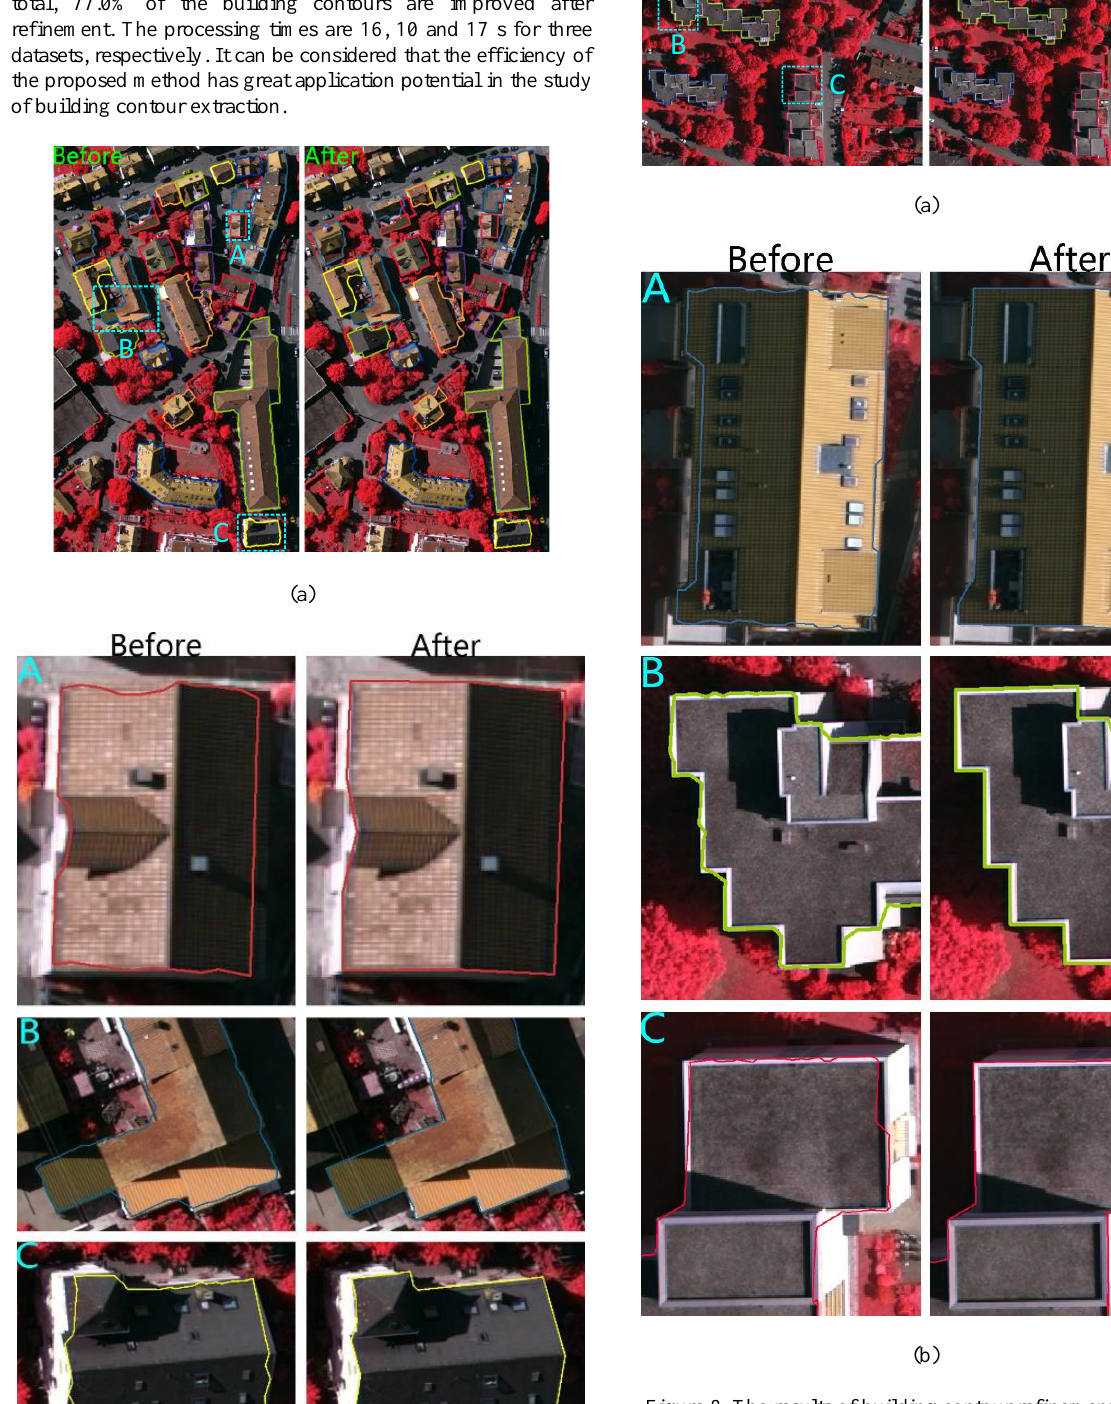
Figure 8. The results of building contour refinement of Area